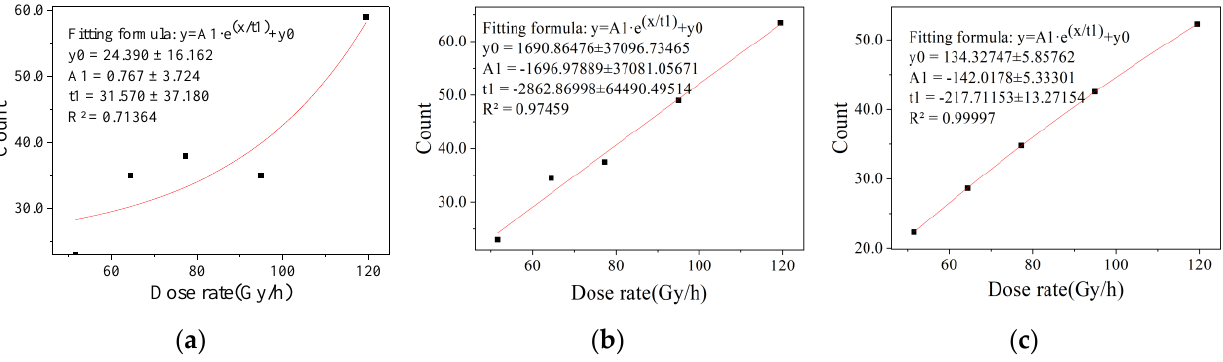
Figure 6. Convergence efficiency of binarized eigenvalue in dark image irradiation chamber. ( a ) 1 frame of image data, ( b ) 2 frames of image data and ( c ) 50 frames of image data.